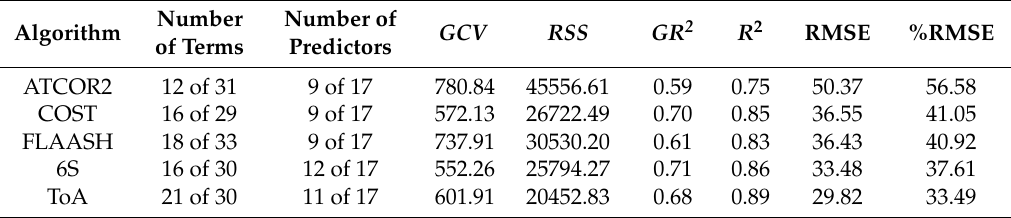
Figure 6. Importance and selection of predictor variables in the multivariate adaptive regression splines (MARS) models for each radiometric correction algorithm considered. Table 3. MARS model selection criteria for AGB estimation and the different radiometric correction algorithms considered.